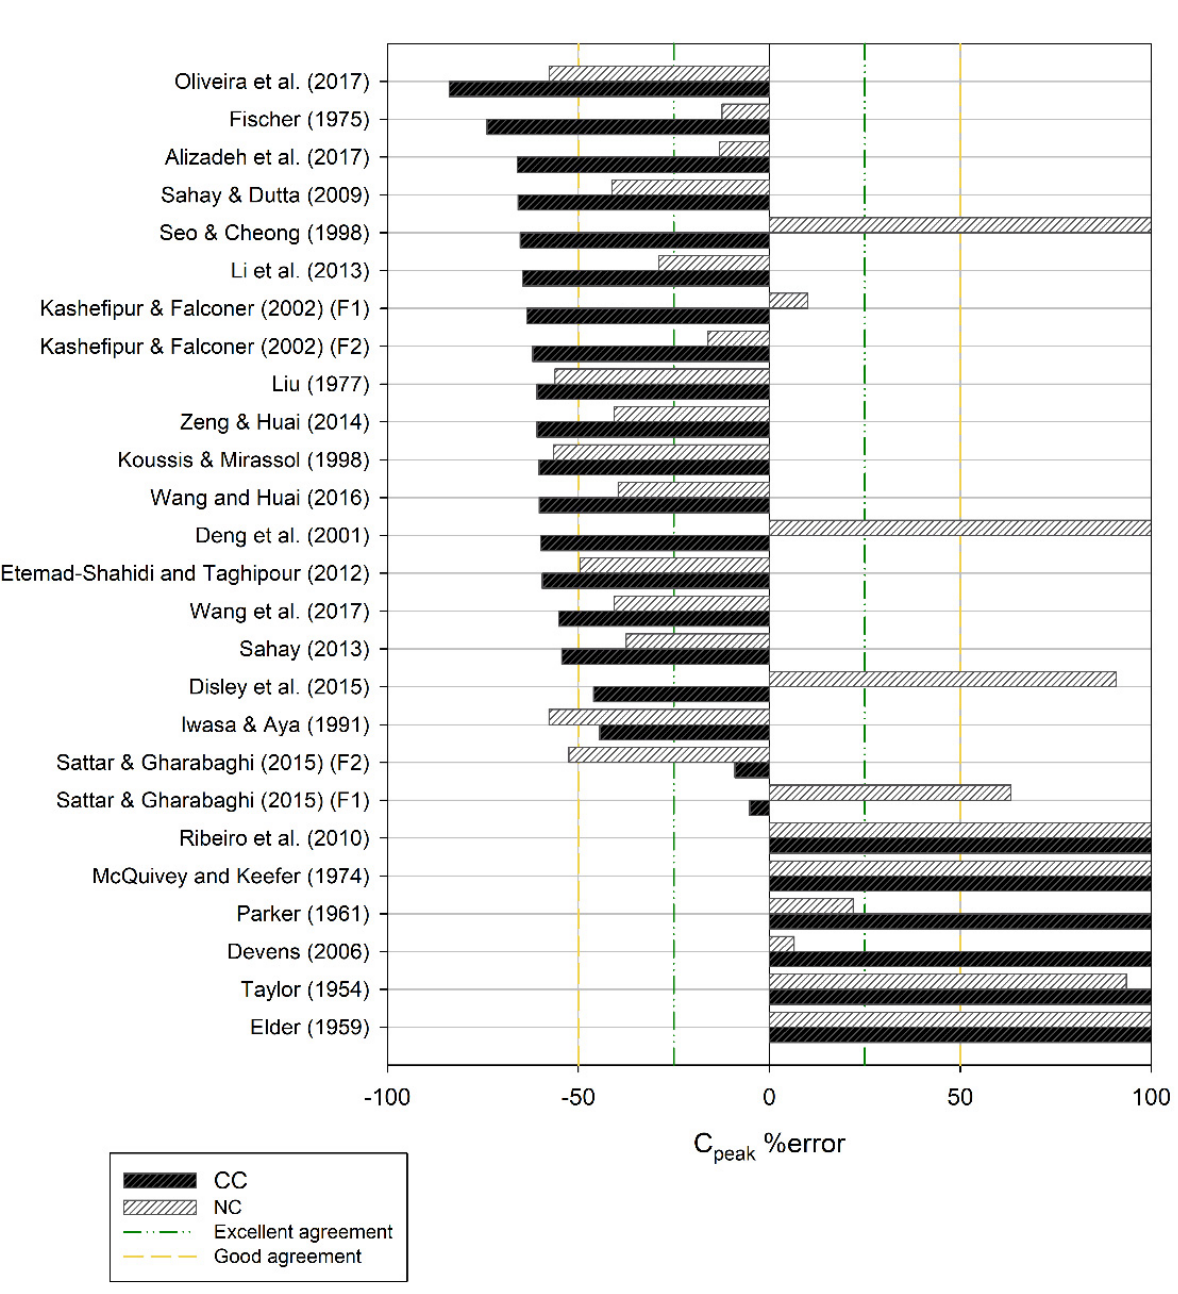
Figure 12. Peak concentration relative error for the concrete and natural channels.